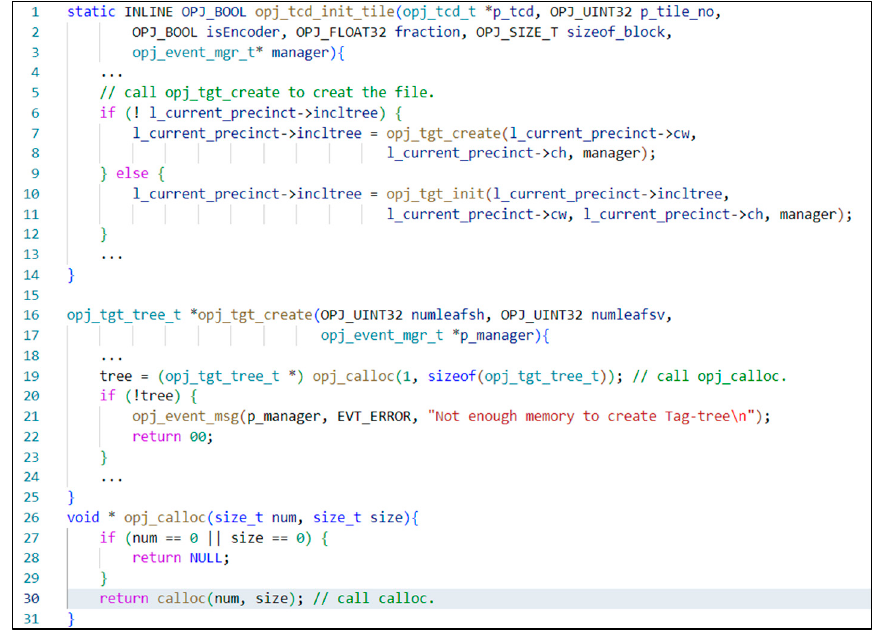
Figure 1. Code snippet from tcd.c/tgt.c in OpenJPEG v2.3.0.